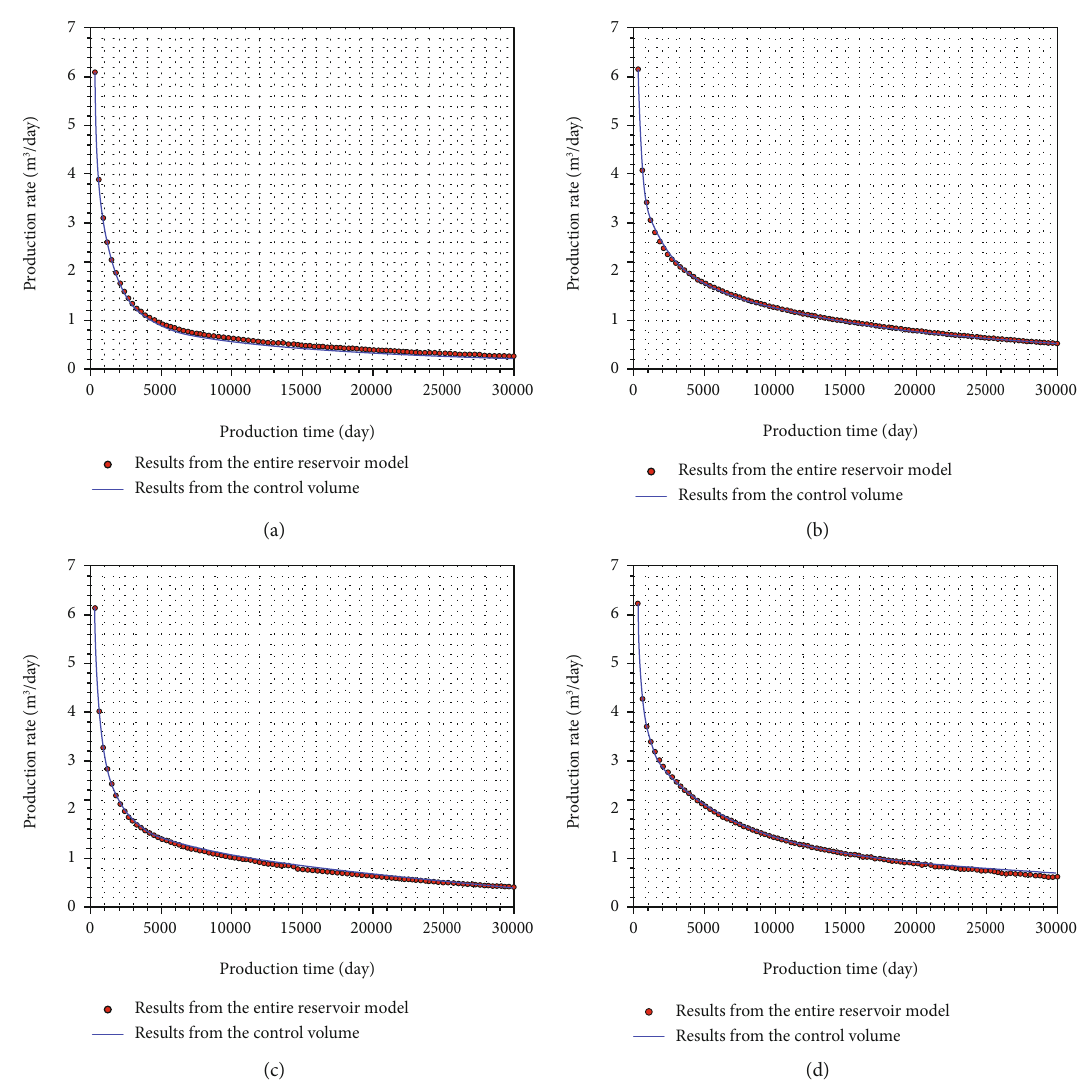
Figure 6: Comparison between the well performance that is predicted with the control volume to that with the entire reservoir model #1: (a) results of well #1, (b) results of well #2, (c) results of well #3, and (d) results of well #4.